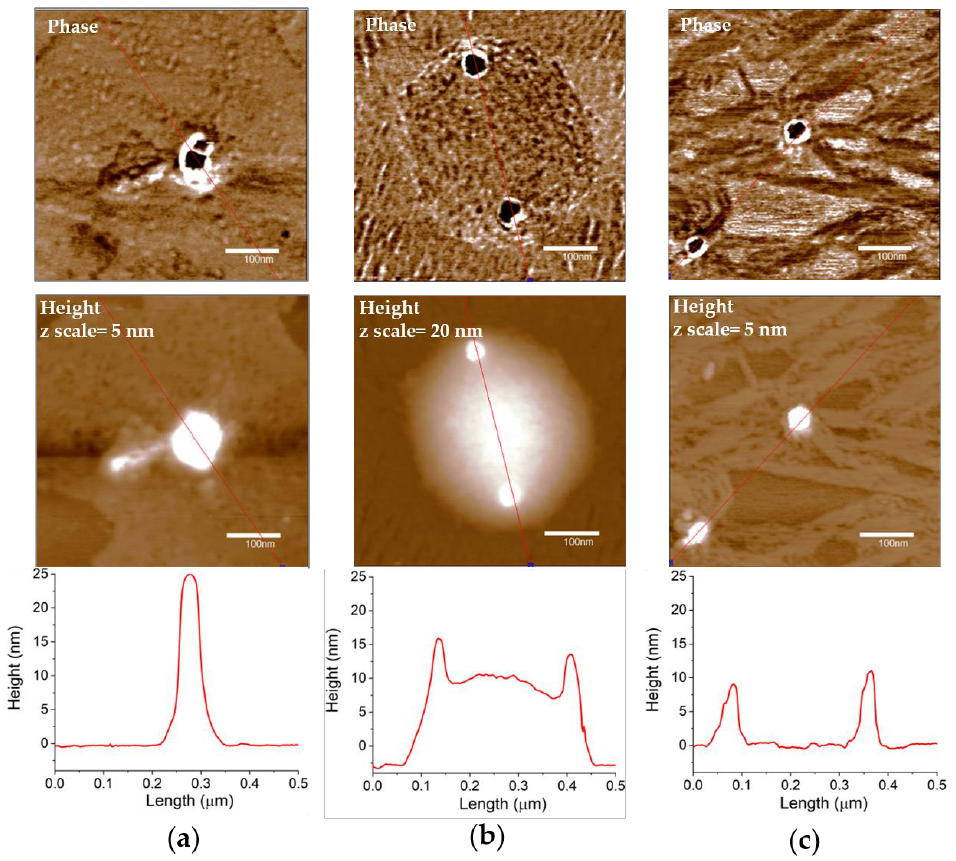
Figure 4. Atomic force microscopy (AFM) images recorded on a scan size of 500 × 500 nm 2 in air AC mode of phase (upper panels) and height (middle panels) with related section analysis curves (lower panels) for: ( a ) bare AuNP, ( b ) HA-capped AuNPs with HA 200 kDa and ( c ) HA-capped AuNPs with HA 700 kDa.